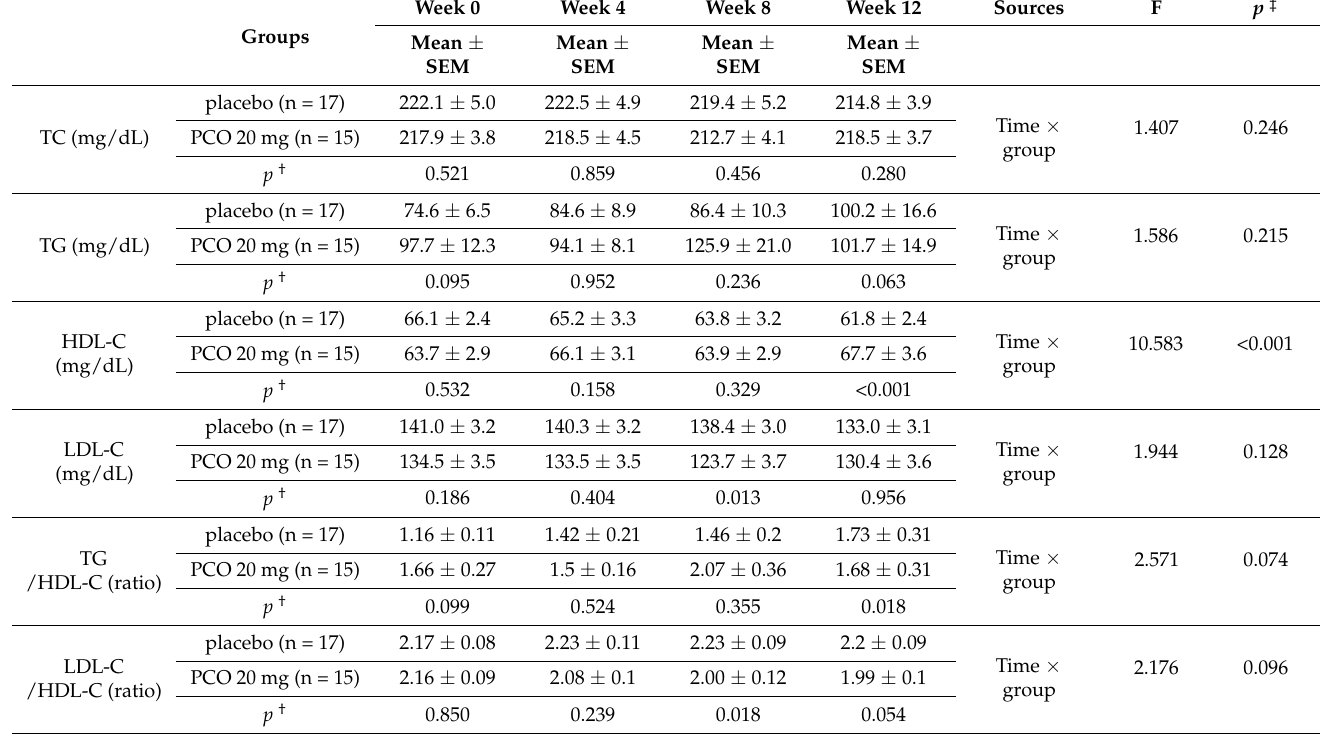
Table 2. Repeated measures ANOVA of blood lipid parameters between the policosanol (PCO, 20 mg) and placebo groups